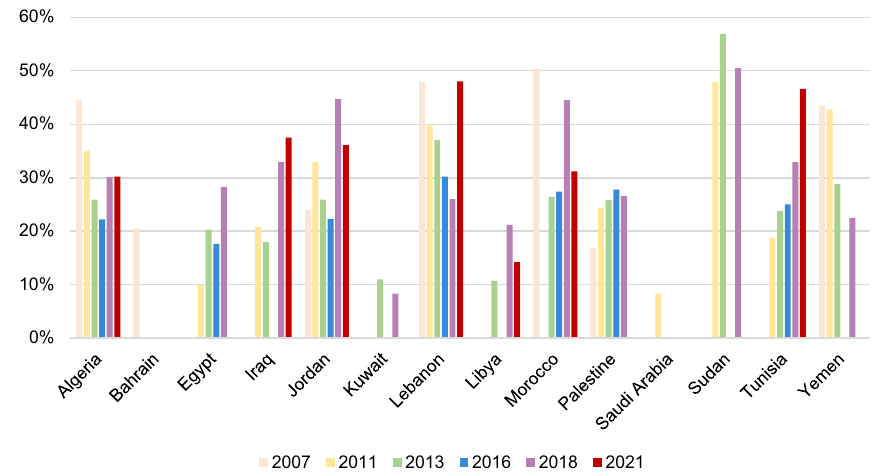
Fig. 1 Propensity to emigrate by country, 2007–2021. Notes: Weighted. Arab Barometer I, II, III, IV, V, VI. Percentage responding “yes” to “Some people decide to leave their countries to live somewhere else. Have you ever thought about emigrating from your